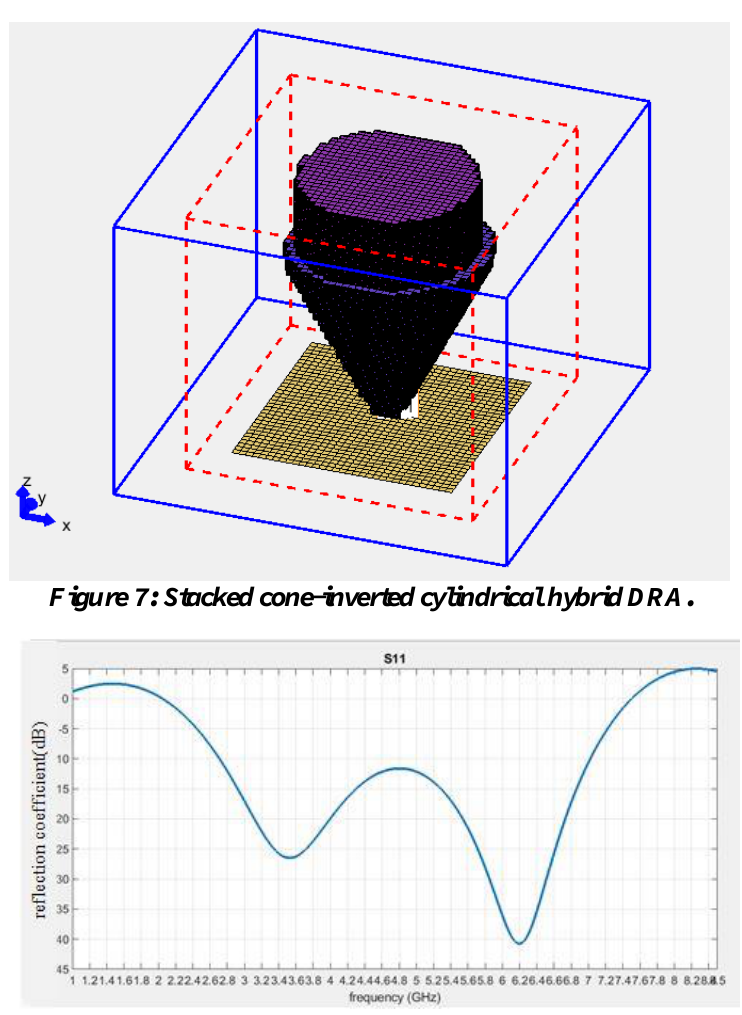
Figure 8: Return loss for stacked cone-inverted cylindrical hybrid